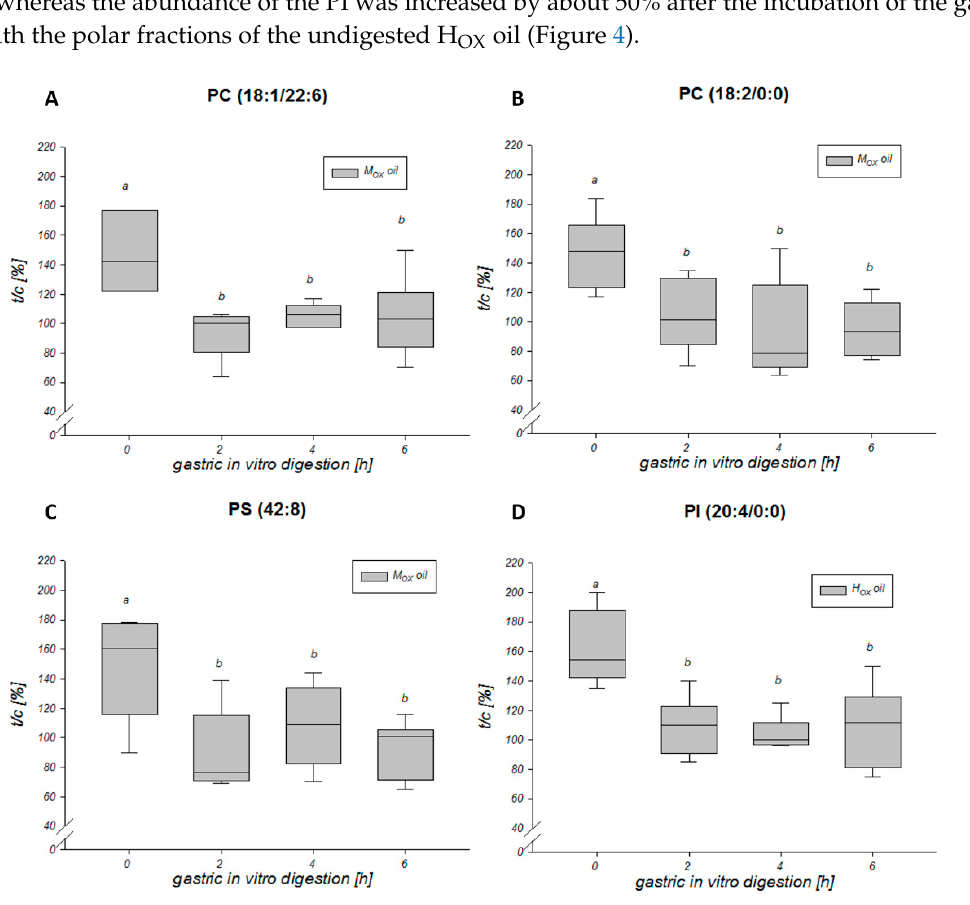
Figure 4. Effect of the oxidized lipids from the grape seed oils digested in vitro for 0, 2, 4, and 6 h on phospholipids in the HGT-1 cells. The phospholipids ( A ) phosphocholines PC (18:1 / 22:6), ( B ) PC (18:2 / 0:0) and ( C ) phosphoserine PS (42:8) were modulated by treatment of the HGT-1 cells with